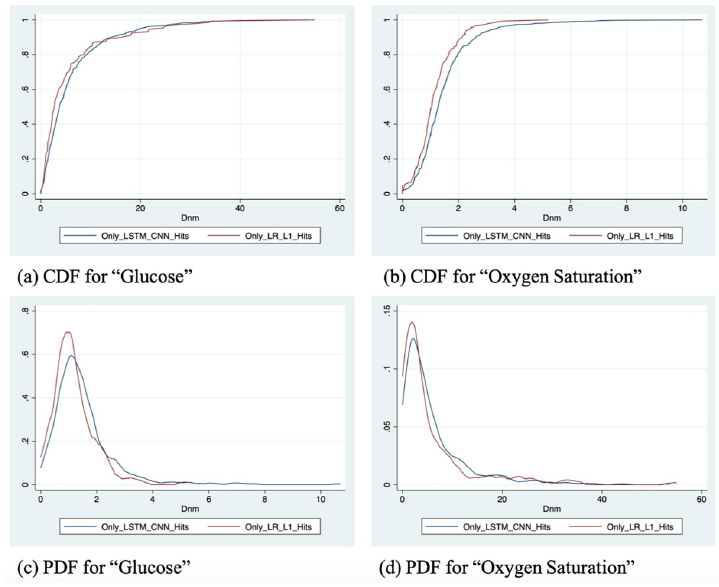
Fig 10. Cumulative density function (CDF) plots and probability density function (PDF) plots.